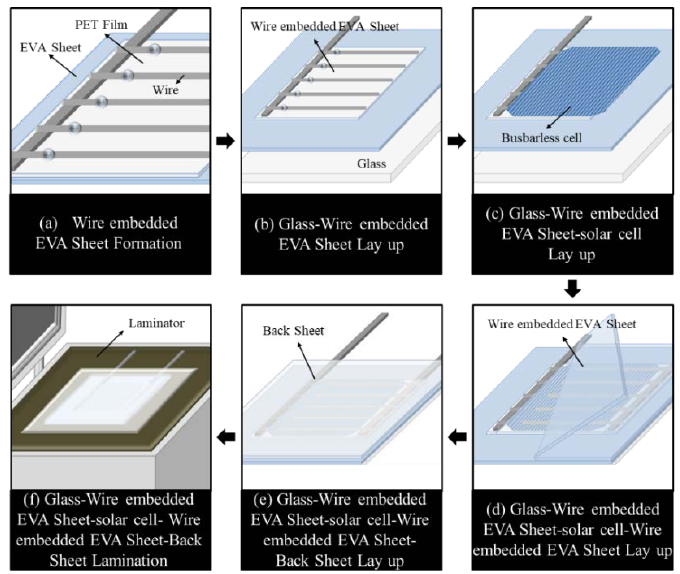
Figure 1. Wire-embedded EVA sheet module process flow.